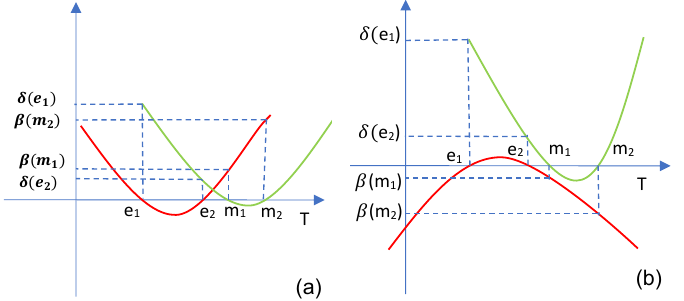
Figure 2. Graphical representation of ∆ 1,2 . Case I ( e 1 < e 2 < m 1 < m 2 ) when ( a ) a > 0, h > 0; ( b ) a < 0, h > 0.